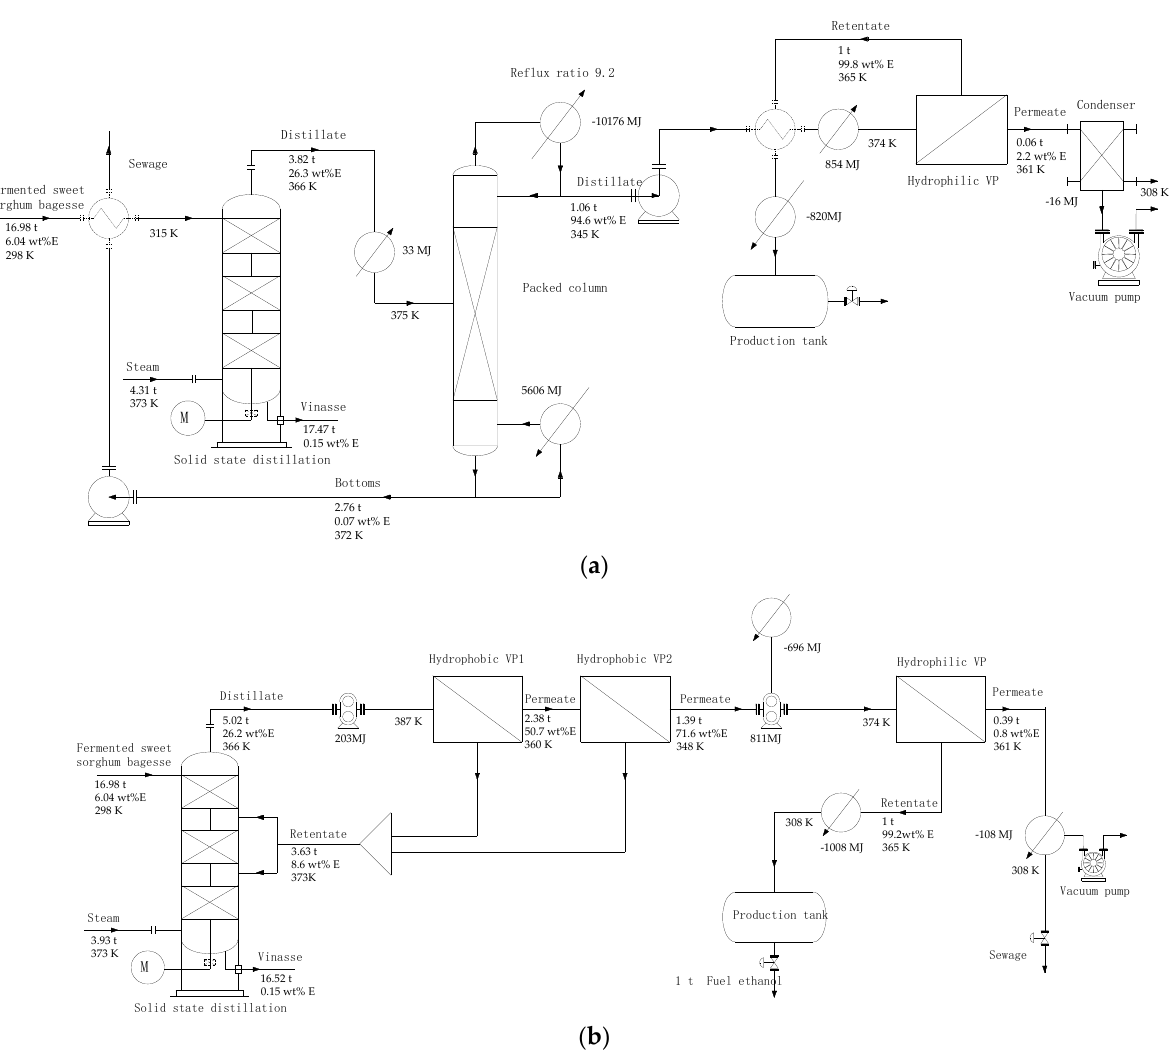
Figure 5. Flowsheets of ethanol-enriching process base on CSSD ( a ) rectification case; ( b ) VP case.